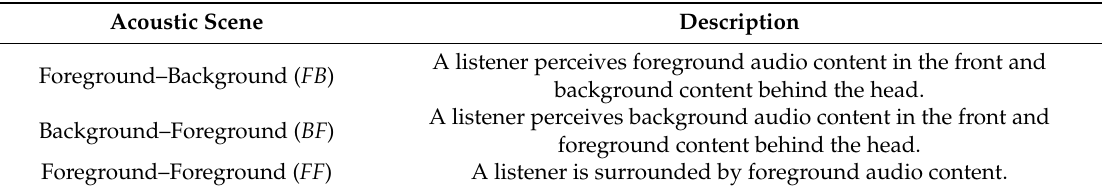
Table 1. The basic spatial audio scenes.